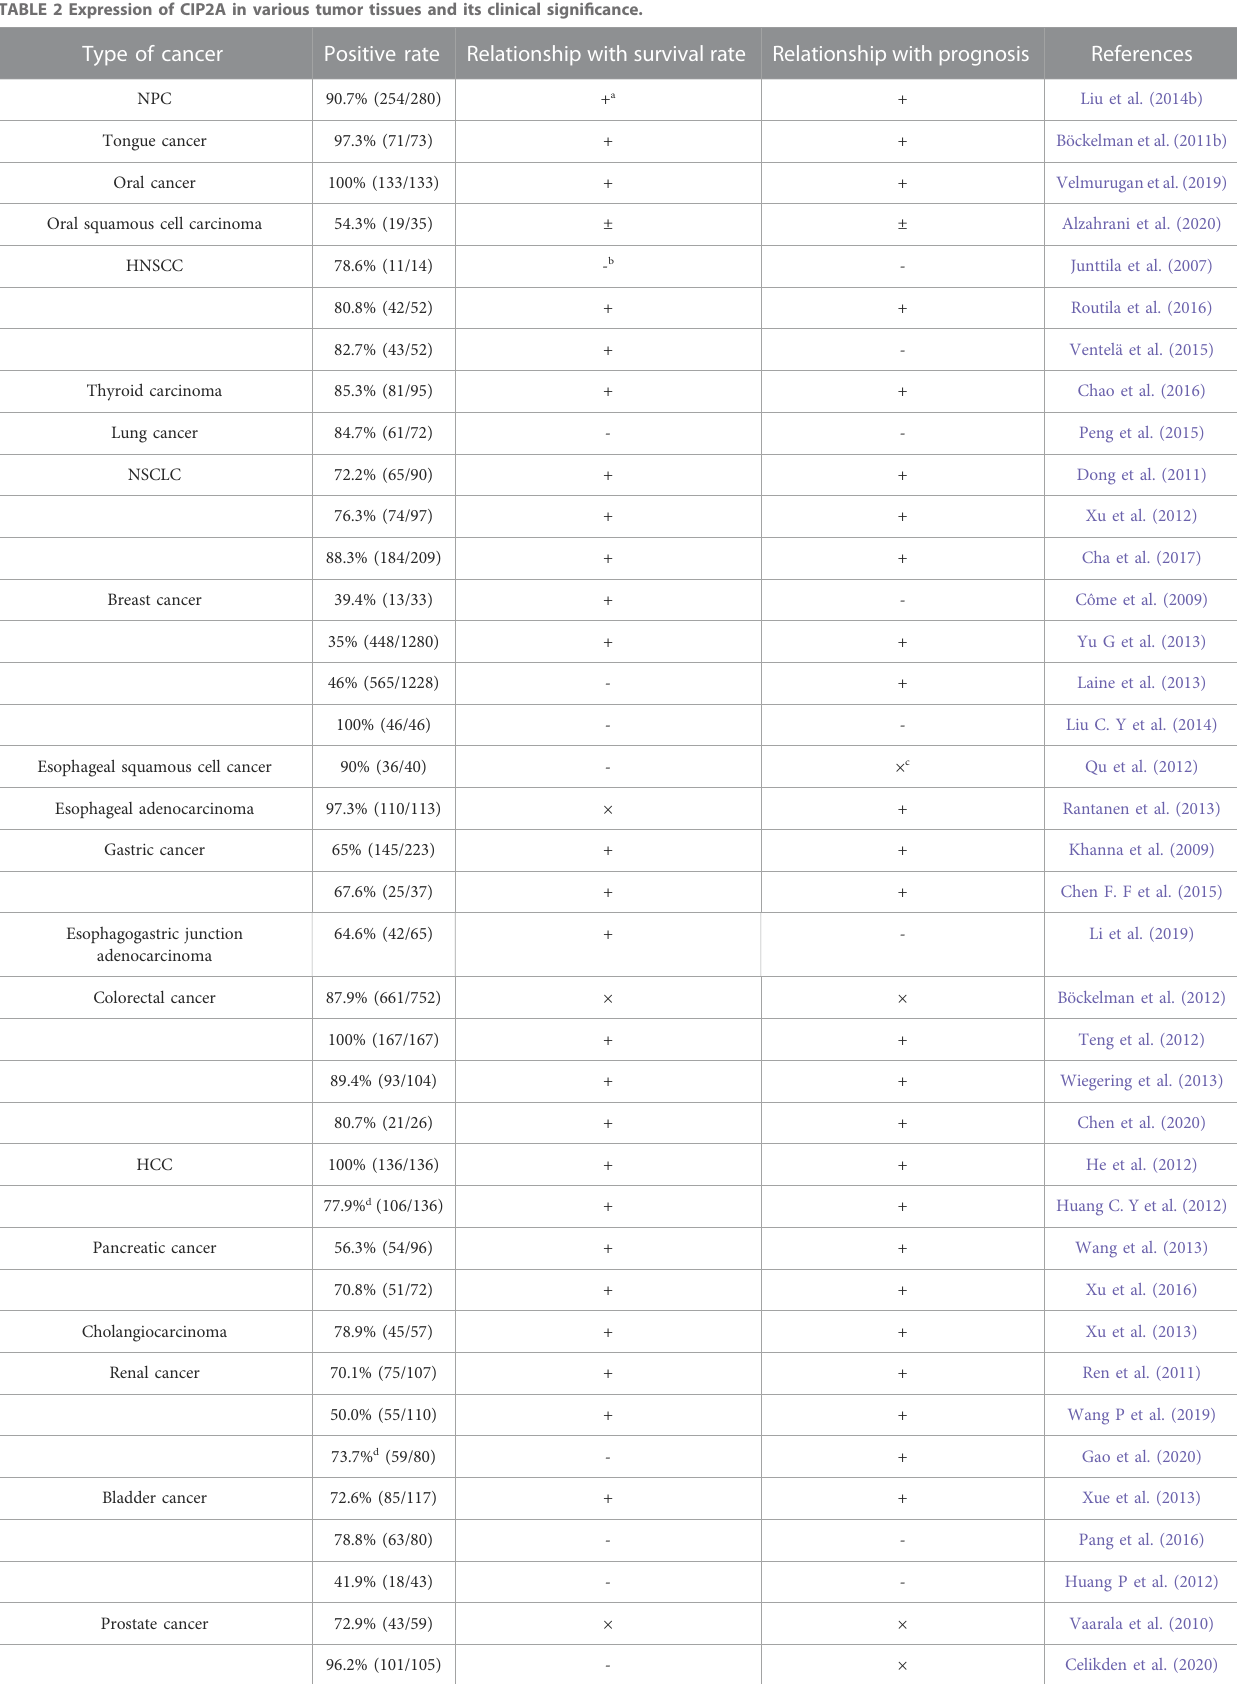
TABLE 2 Expression of CIP2A in various tumor tissues and its clinical signi fi